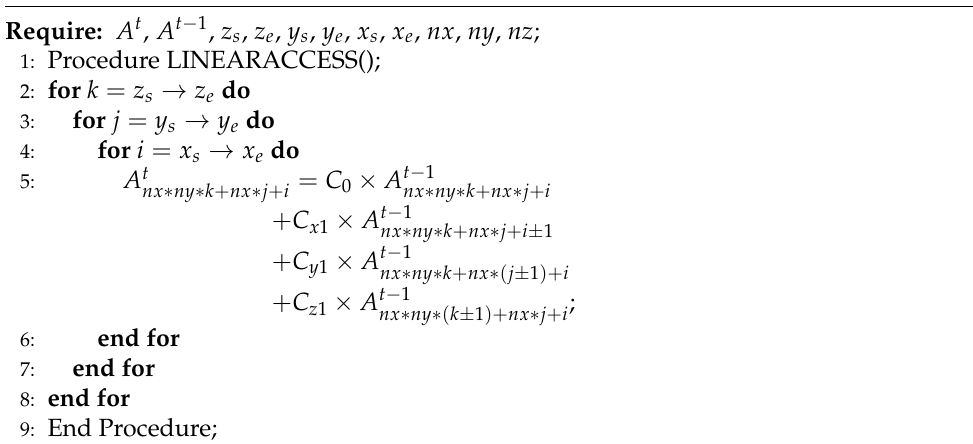
Algorithm 4 Original stencil code with linear array access